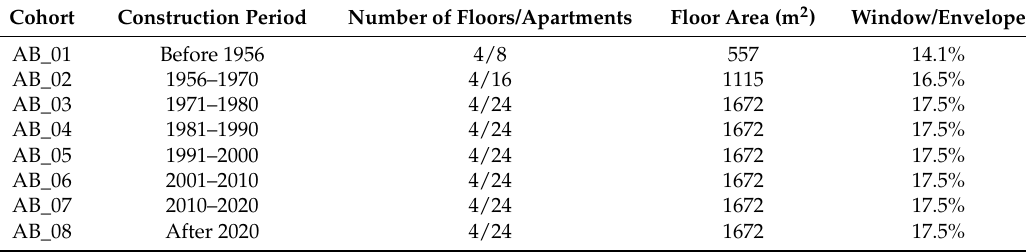
Table 1. Overview of the modelled age classes and their geometrical